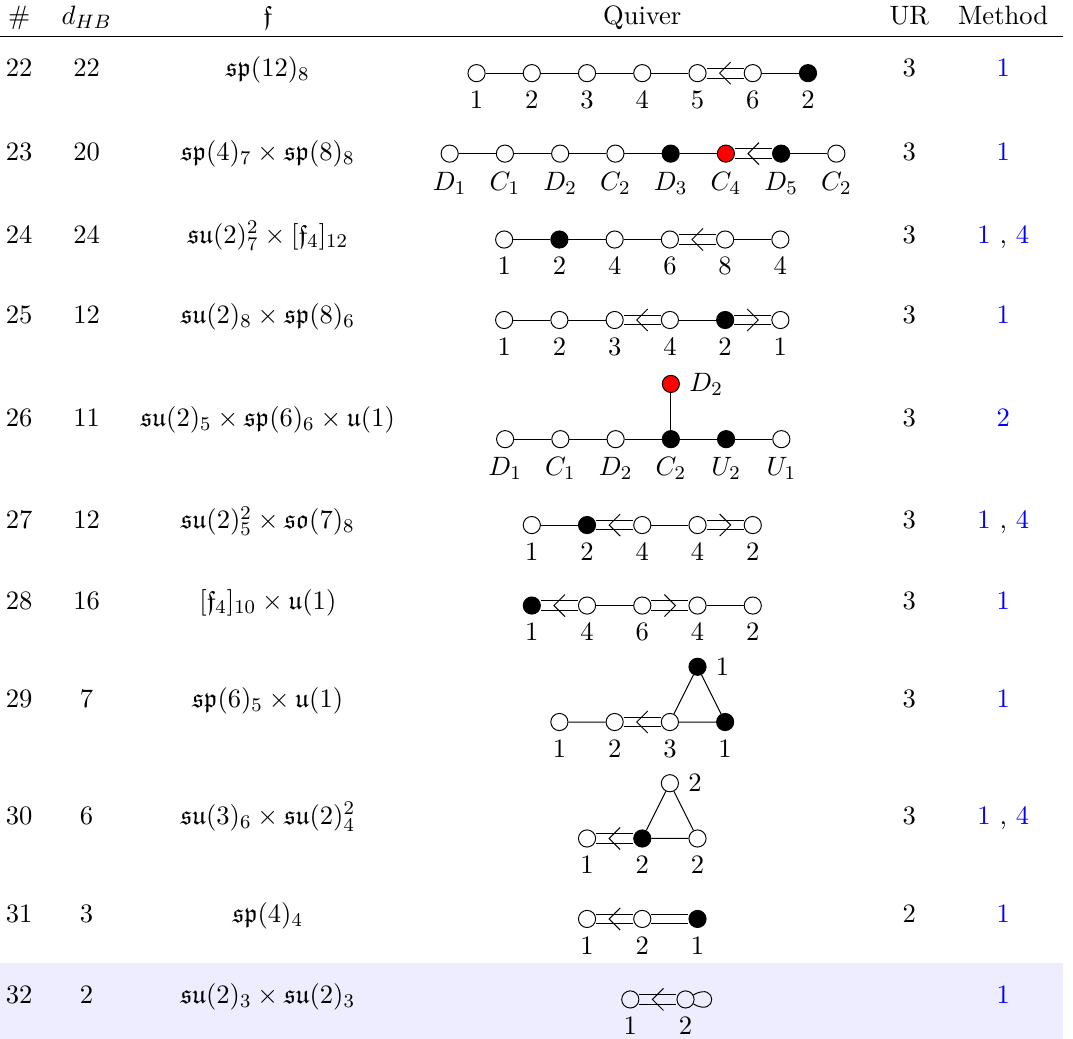
Table 3 . List of magnetic quivers (continued). Lines shaded in blue correspond to 4d